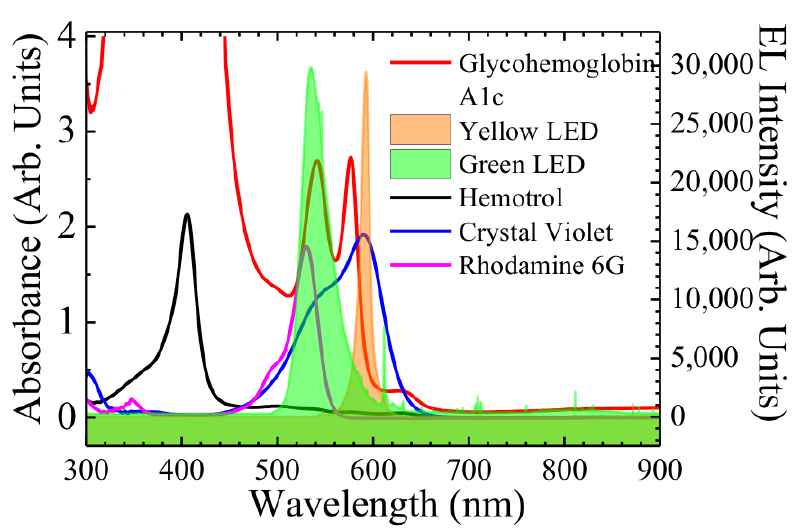
Figure 2. Electroluminescence of green and yellow LED measured at room temperature compared to the absorbance of Glycohemoglobin A1c, Hemotrol, crystal violet, and rhodamine 6 g